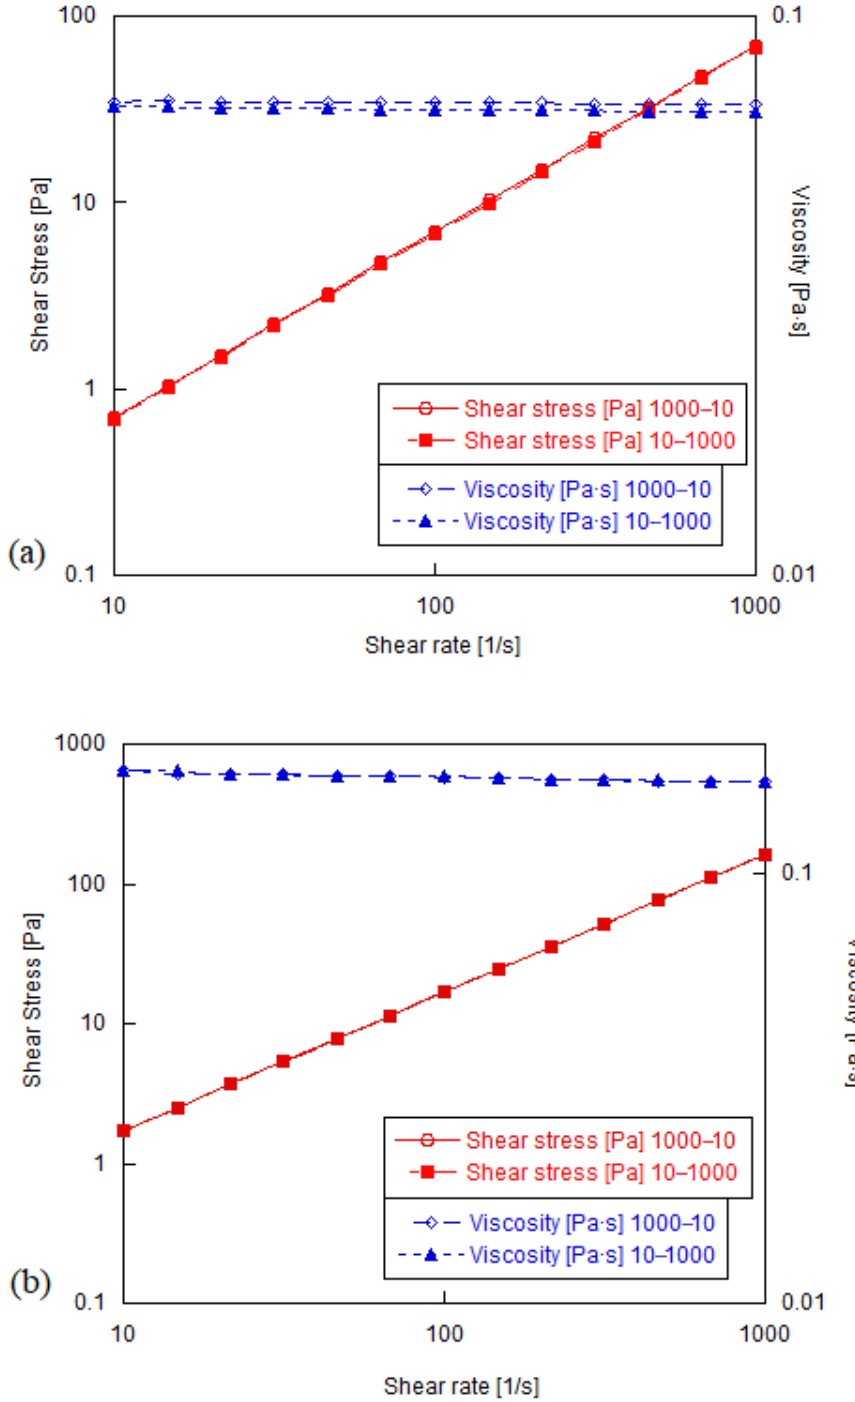
Figure 9. Flow curve applying a shear rate of 10 to 1000 s − 1 (filled symbols) and then 1000 to 10 s − 1 (open symbols) for suspensions of GO 2 h with concentrations of ( a ) 0.1 and ( b ) 80 mg/mL.